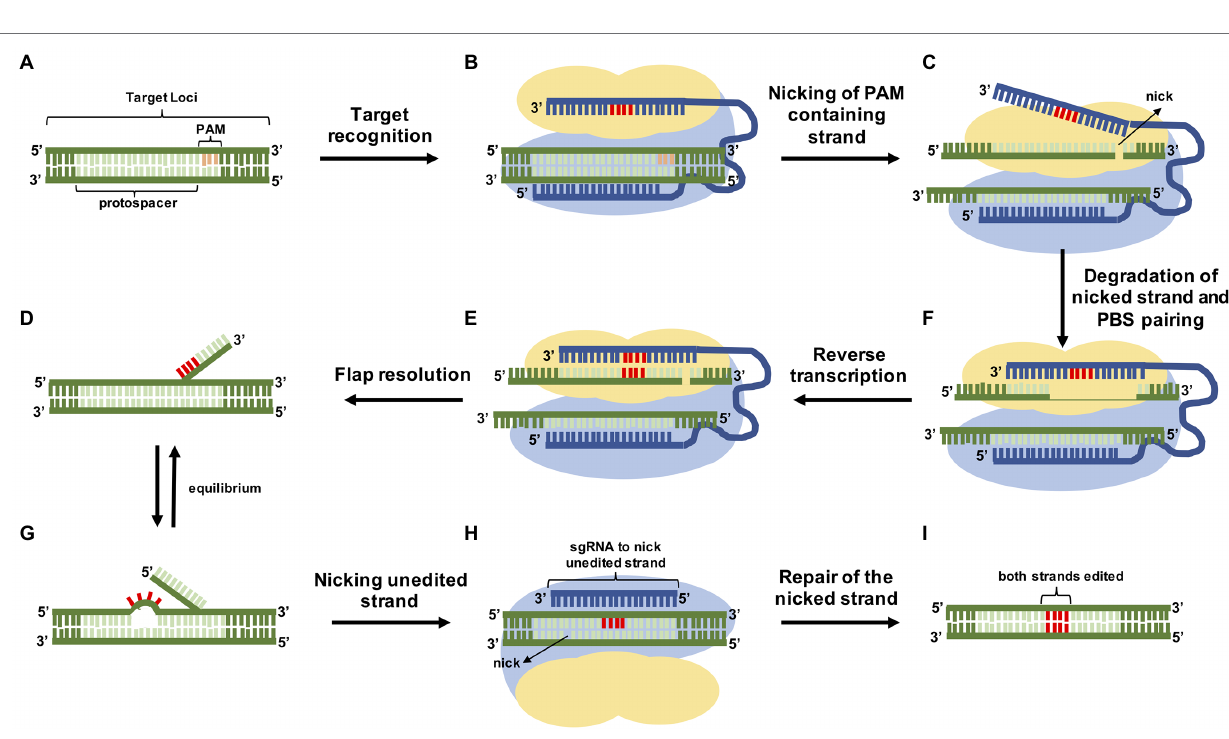
FIGURE 3 | Overview of precise genome modification using prime editing. At the genomic site (A) , the nCas9 (H840A) is led to the target by the pegRNA (B) and breaks just the strand containing the PAM of the DNA duplex (C) exposing a 3 ′ -hydroxyl group (3 ′ flap), that, together with the extension of the pegRNA PBS (D) is used to prime the RT reaction, inserting the edit (E) . The editing area contains two single-stranded flaps in equilibrium: the 3 ′ flap containing the edition (F) and the 5 ′ unedited flap (G) . The endogenous cellular endonucleases prefer 5 ′ flaps as a substrate digesting it and leaving the 3 ′ flap to be ligated. At the end of the process the nicked DNA strand is replaced by the newly synthesized strand that had the information copied from the pegRNA generating a heteroduplex. In this case, the repair mechanism is going to resolve the mismatch using one of the strands, so there is a 50% chance of the edition being repaired by the cell. To overcome this setback, the induction of a second nick on the unedited strand using a sgRNA (H) stimulates the repair by copying the information present on the edited strand (I)